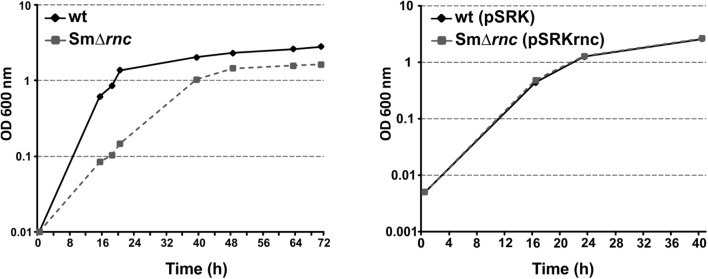
Free-living phenotype of the SmΔrnc mutant. Growth curves of parent (wt; wtpSRK), mutant (SmΔrnc), and complemented (SmΔrncpSRKrnc) strains as determined by OD600 readings of TY cultures. Growth of wild-type bacteria harboring the empty vector pSRK was used as the control reference for the complemented strain.